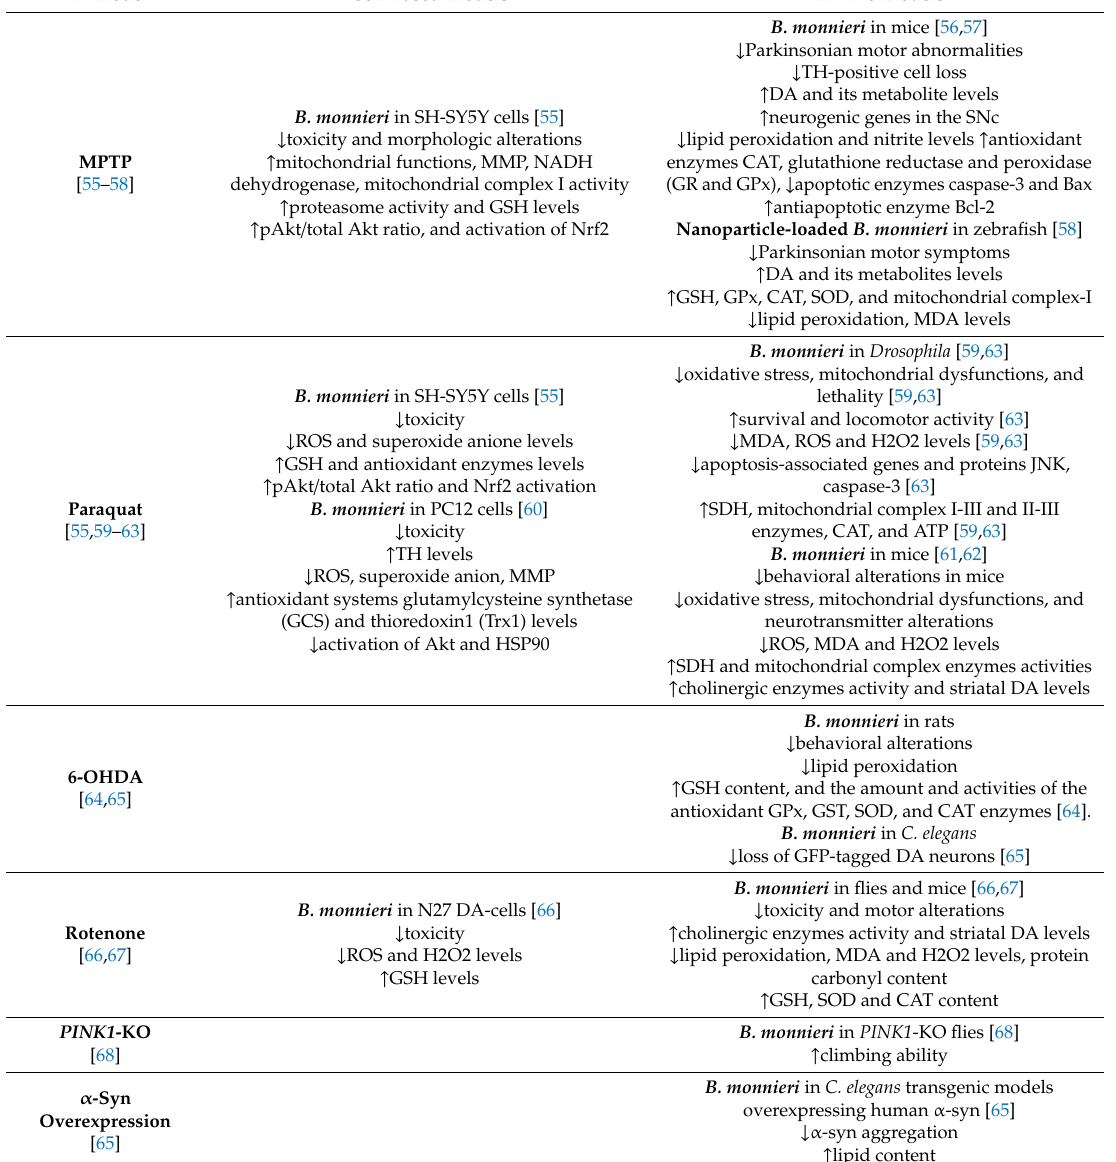
Table 2. Neuroprotective e ff ects of Bacopa monnieri in PD